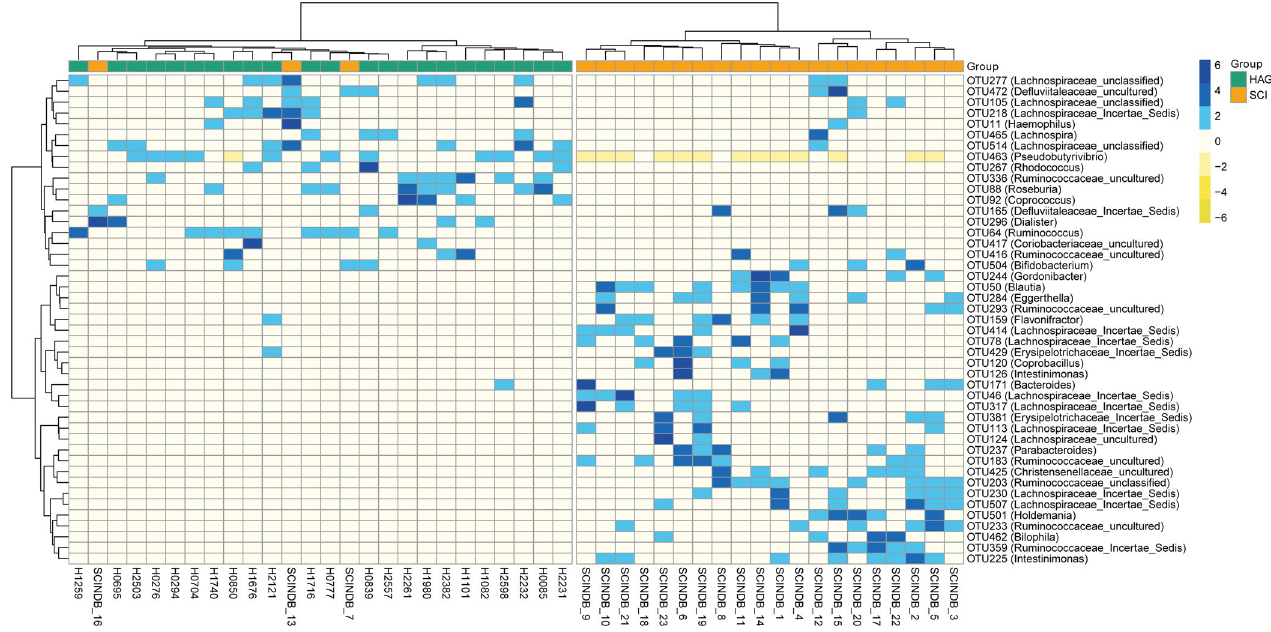
Fig 4. A two-dimensional heatmap showing the relative abundance of 45 dominant genera in 23 patients with SCI and 23 healthy controls. Rows represent the 45 bacterial genera, which were significantly enriched either in SCI or healthy samples, columns represent the 46 samples of SCI or healthy samples. The upper 18 OTUs exhibited higher relative abundance in the healthy group, and the lower 27 OTUs exhibited higher relative abundance in the SCI group. OTUs, operational taxonomic units. SCI, spinal cord injury group (orange); HAG, healthy group (green).